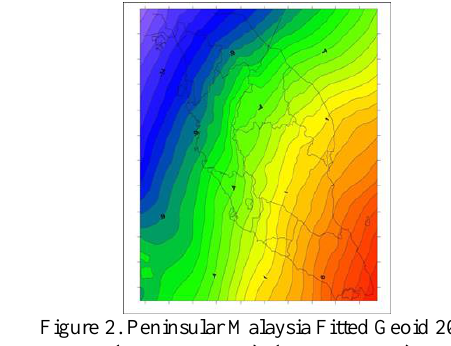
Figure 2. Peninsular Malaysia Fitted Geoid 2004